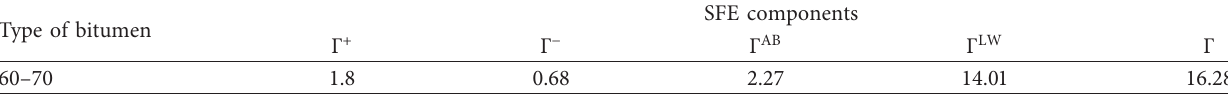
Table 8: Bitumen SFE components (ergs/cm 2 ).